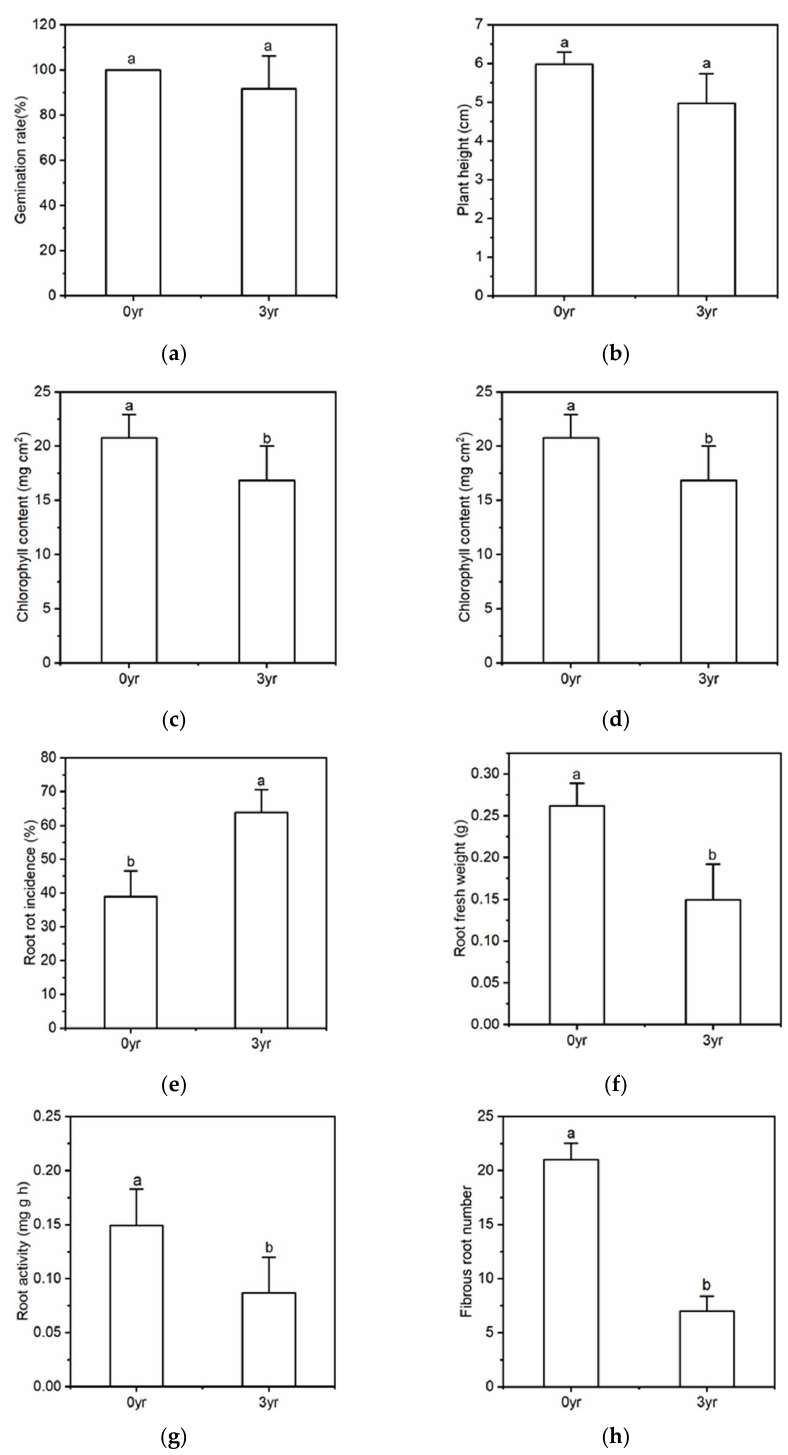
Figure 2. The effects of soil with different monoculture history on the growth of American ginseng: germination rate ( a ); plant height ( b ); leaf chlorophyll content ( c ); root morphology ( d ); incidence of root rot ( e ); root fresh weight ( f ); root activity ( g ); numbers of fibrous root ( h ); 0 yr: no growing history; 3 yr: 3-year monoculture. Bar: standard error of the mean (n = 3); different letters represent significant differences according to one-way ANOVA analysis ( p < 0.05). The detailed information of the ANOVA results are shown in Table A1.